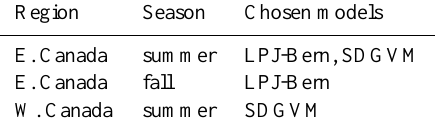
Table 1. Spatial flux patterns chosen by the model selection frame- work.